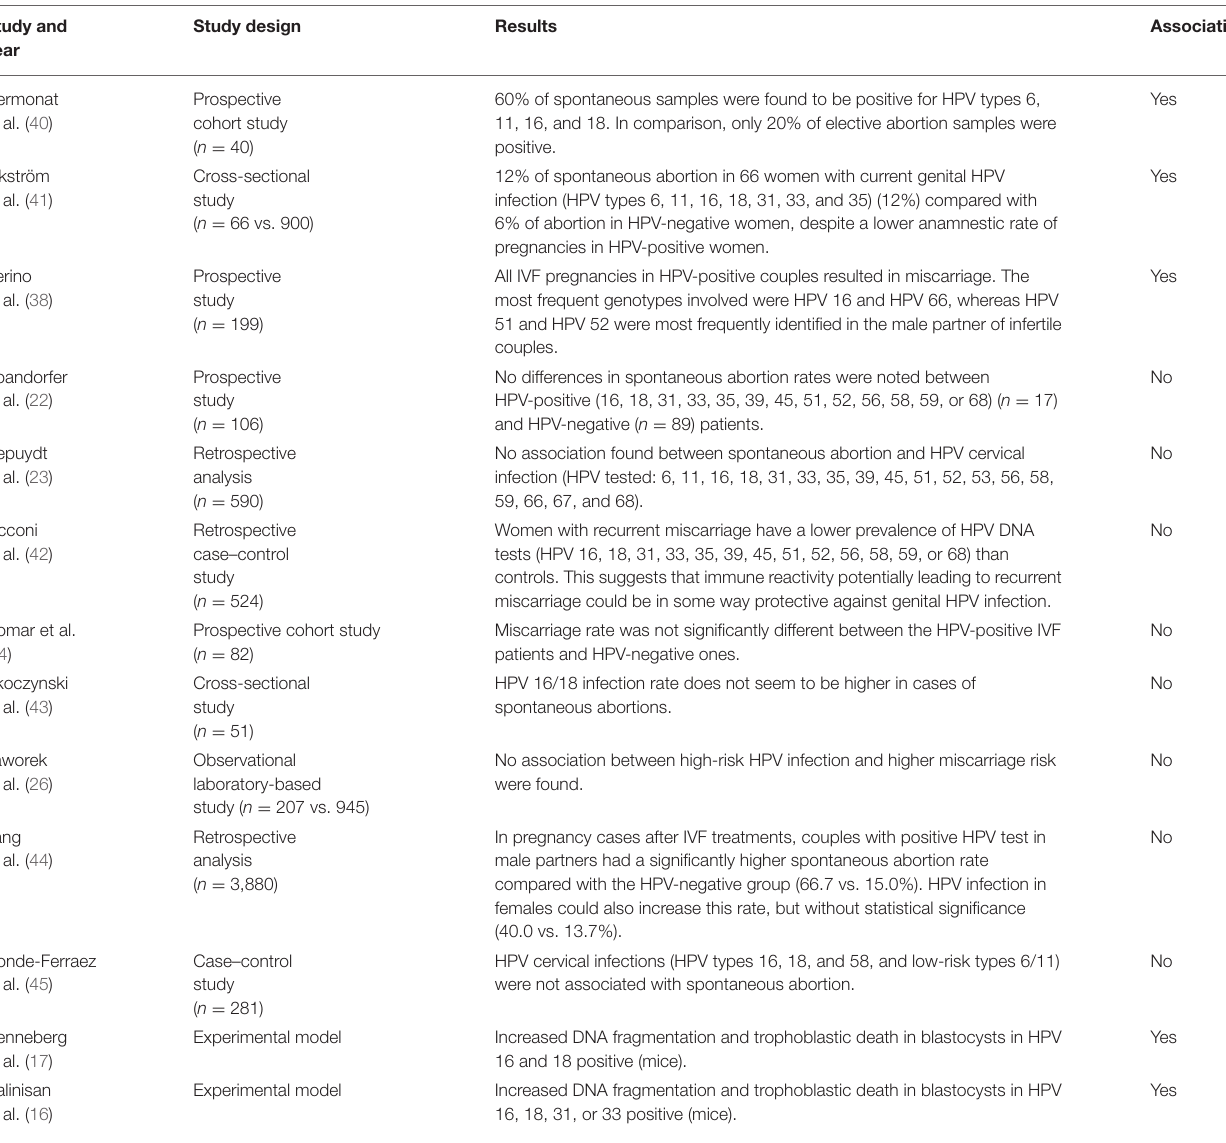
TABLE 3 | Literature regarding the effect of HPV genotypes included in the 9-valent vaccine on the risk of